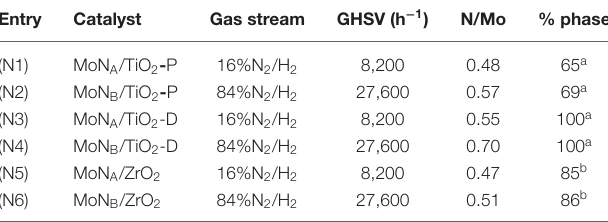
TABLE 2 | List of the supported molybdenum nitride catalysts with the corresponding preparation conditions, the N/Mo atomic ratio derived from elemental analyses, and the support composition (%